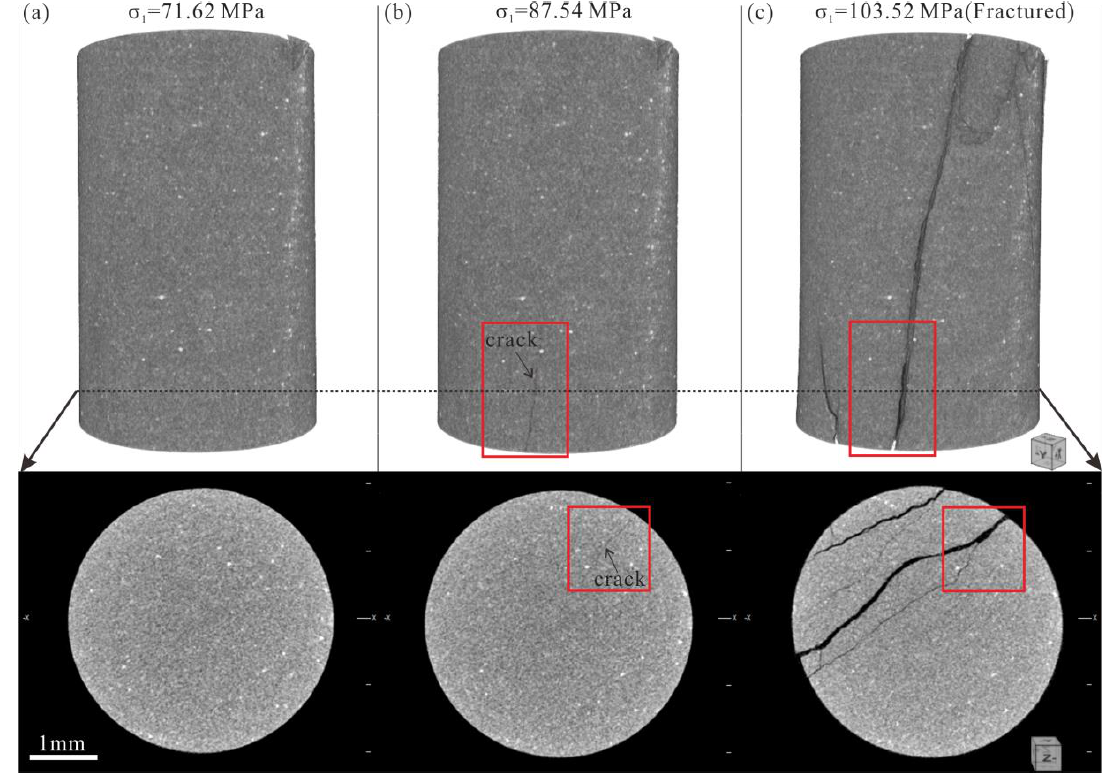
Figure 8. Specimen SZA4 at different load stages. ( a ) σ 1 = 71.62 MPa; ( b ) σ 1 = 87.54 MPa; ( c ) Fractured specimen (after σ 1 = 103.52 MPa).